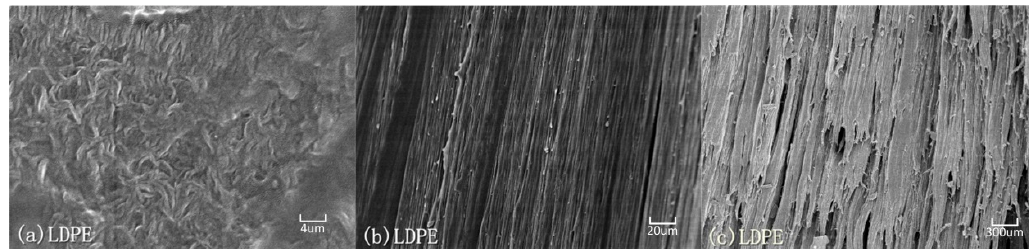
Figure 7. Tensile engineering stress-strain curves of LDPE and UHMWPE at 0° angle and strain rates of 0.001 s − 1 (5.7 mm/min) and 0.01 s − 1 (57 mm/min).